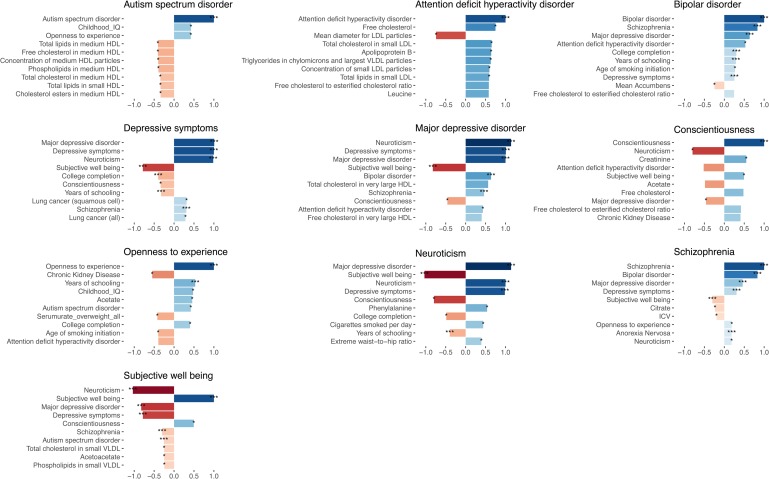
Genetic correlations between psychiatric disorders and traits, and almost 200 other traits. For each trait, the 10 traits with the highest absolute genetic correlations are shown. Colours indicate whether genetic correlations are positive or negative. One star indicates a genetic correlation p value <0.05. Three starts indicate a p value below the Bonferroni threshold of 2.81 × 10−6 for 17 766 tested trait pairs. Data obtained from LD Hub (Zheng et al.
2017).